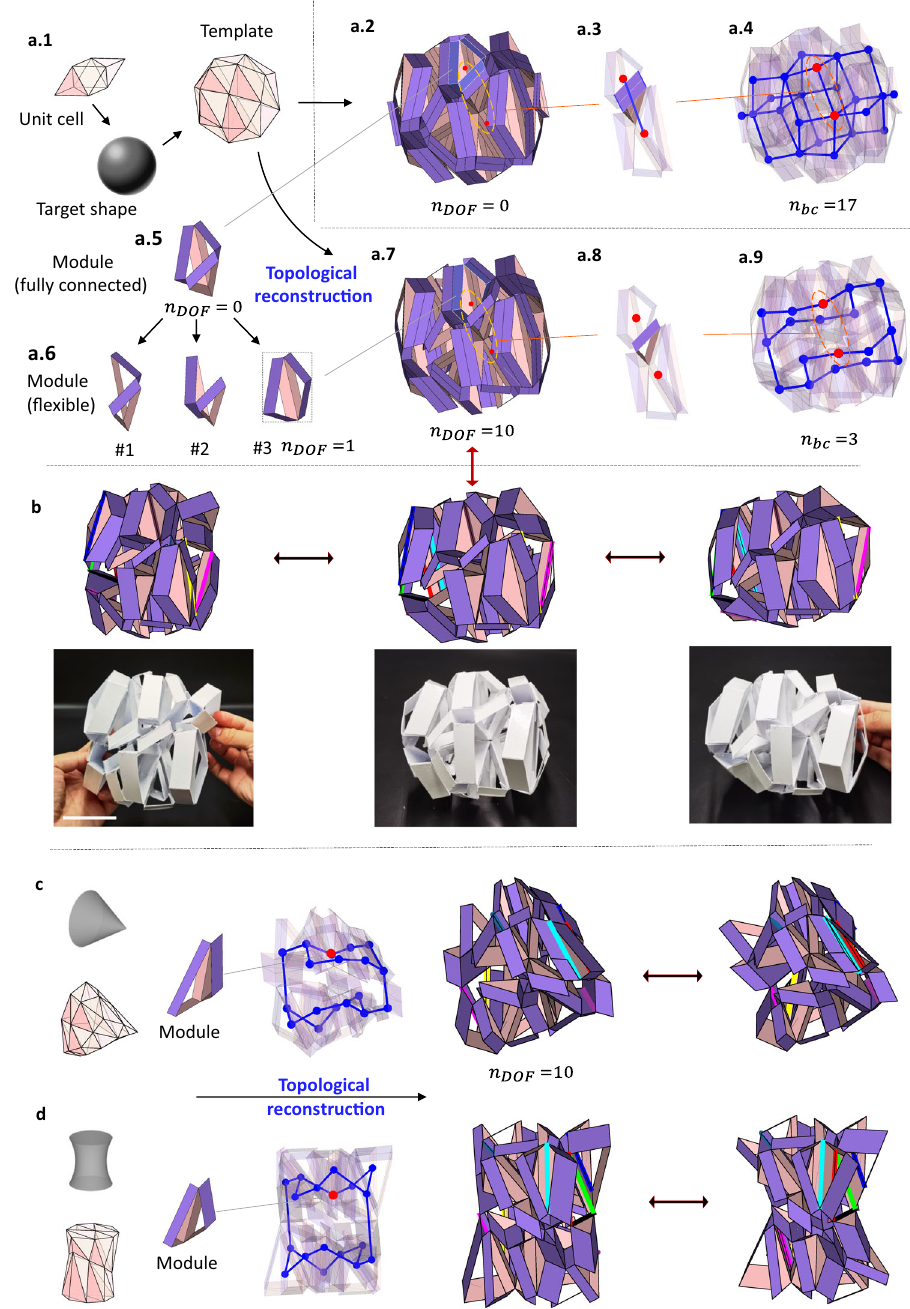
Fig. 3 | Procedure to produce recon fi gurability through topological recon- struction. a .1 Sphere template constructed from the volumetric mapping 2×2×2 ð Þ of a unit cell combining a tetrahedron and octahedron; a .2 Pris- matic architected material after geometric modi fi cation; a .3 Two adjacent modules connected by prismatic tubes; a .4 Construction of a fully connected graph with basic cycles n bc =17; a .5 Rigid module fully connected with tubes; a .6 Modules with nonzero mobility; a .7 Deformable assembly with 10 DOFs after topological reconstruction; a .8 Two disconnected modules; and a